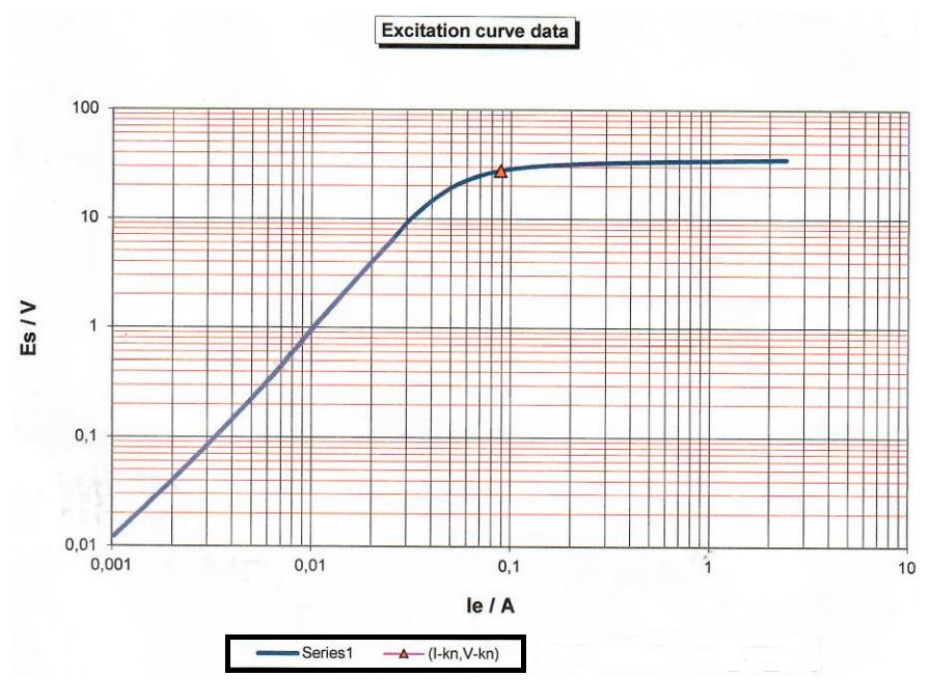
Figure 6. Test result of CT magnetization.